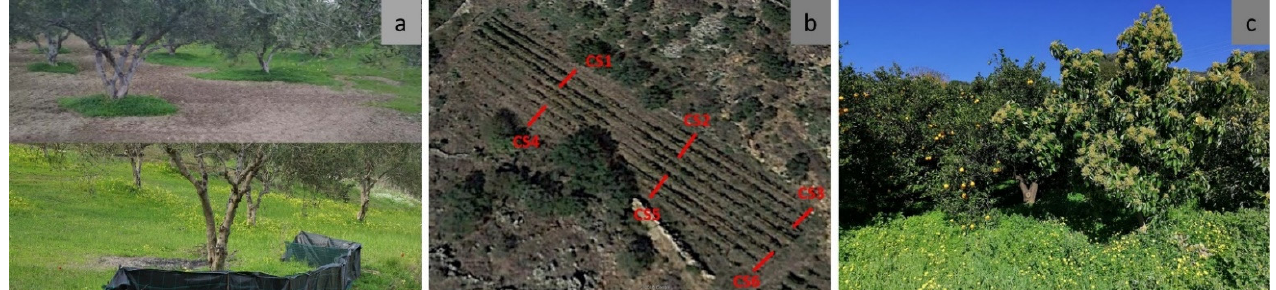
Figure 1. ( a ) Tilled plot (up) and non-tilled plot (down) at the olive orchard site, ( b ) positions of the cross sections (CS) in which soil erosion measurements were performed at the vineyard site, and ( c ) oranges and avocado trees at the fruit orchard field.